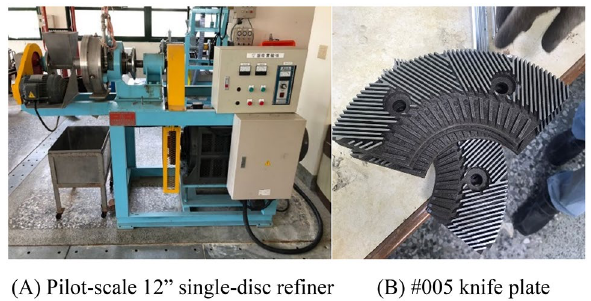
Figure 1. Photos of the pilot-scale 12 ″ single-disc refiner ( A ) and the #005 knife plate ( B